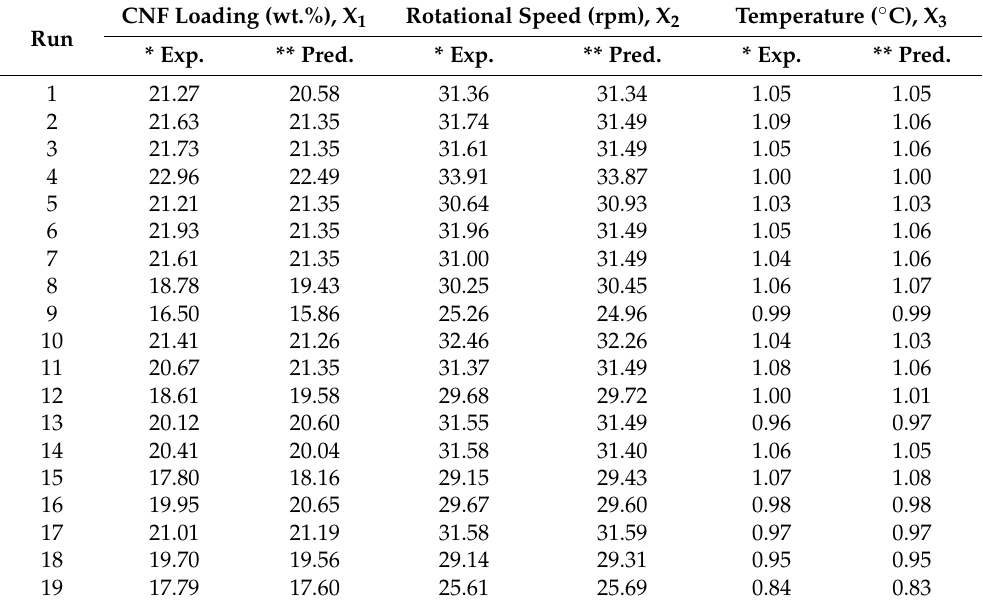
Table 2. The experimental and predicted values of responses. CNF Loading (wt.%), X 1 Rotational Speed (rpm), X Run